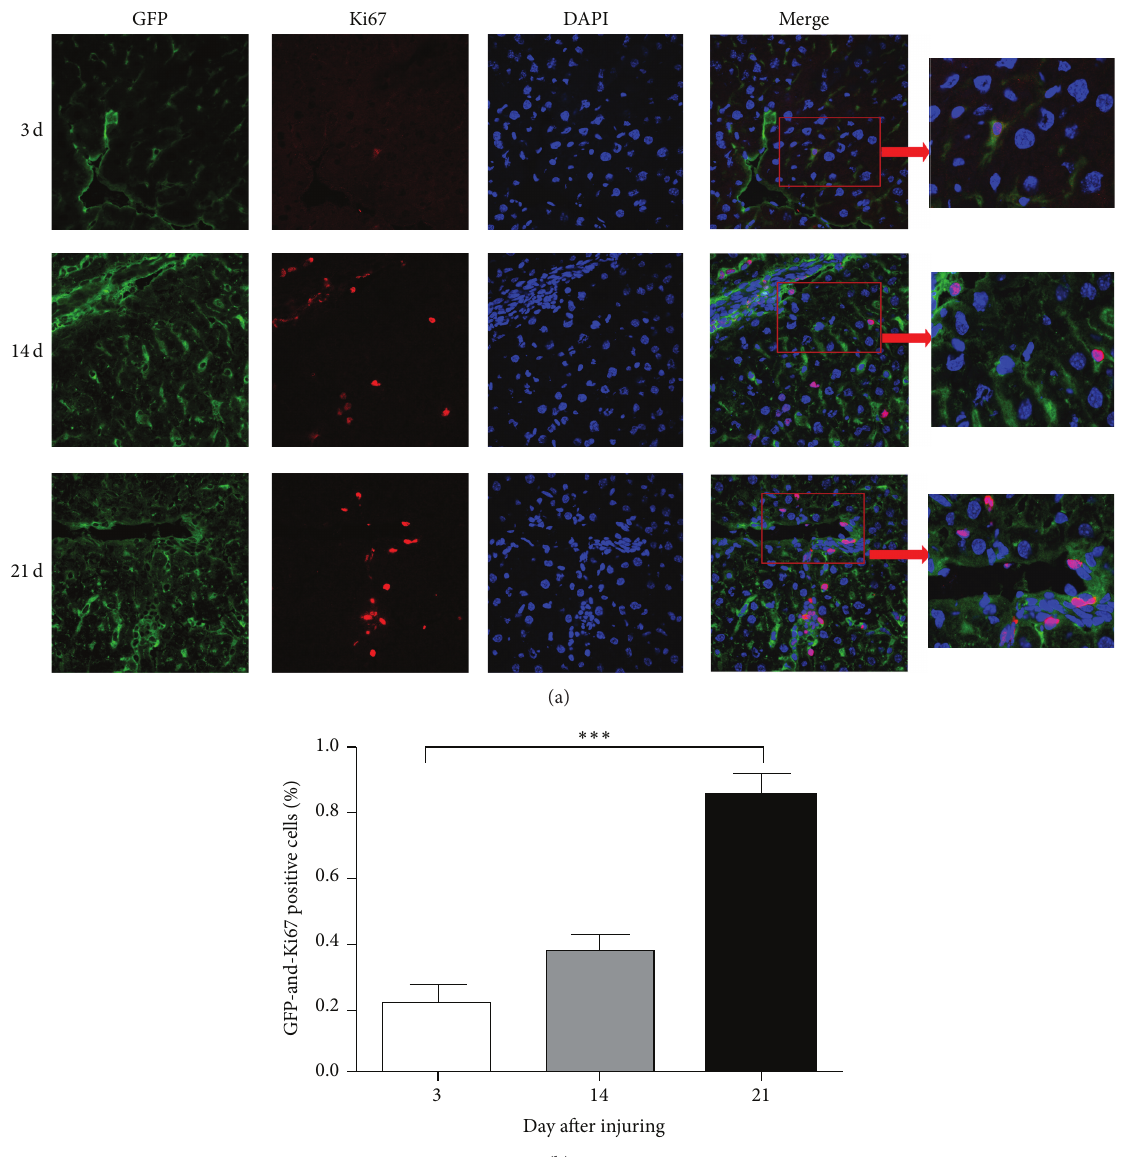
Figure 3: MSCs migrated to the damaged liver and had the proliferative activity. (a) IF analysis of Ki-67 expression (red) to visualize primary hepatocytecellsindicatedthatsomeofthedonorGFP + MSCs(green)areoverlapped.NuclearDAPI(blue)stainingwasusedasacounterstain. The images were then merged. Bar: 75 𝜇 m. Arrow was directed to the double positive cells. All the experiments were repeated three times, at least 3 samples were included in each group. (b) Quantitative data of the GFP and Ki67 positive cells in IHC of different days after injuring ( ∗∗∗ 𝑃 < 0.001